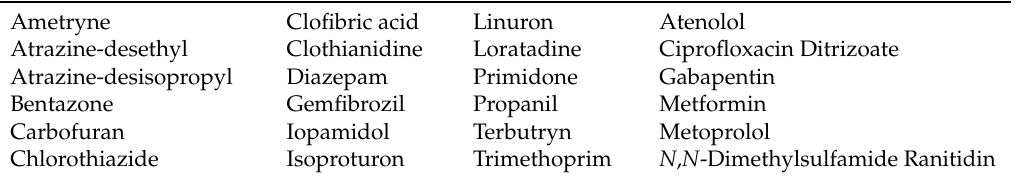
Table A2. List of organic micropollutants not detected in any